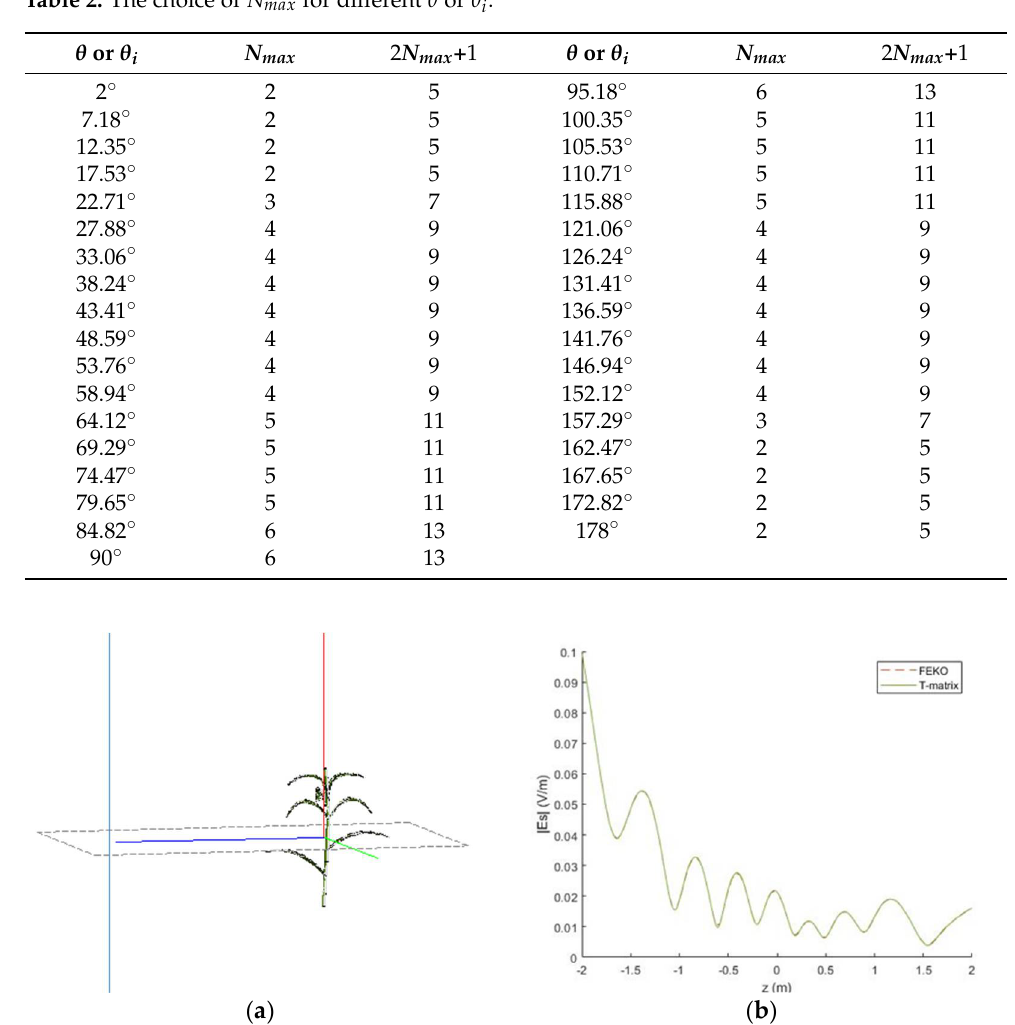
Figure 6. Tree trunks ( left ) are modelled as dielectric cylinders ( right ). The Figure is adapted with permission from Ref. [2]. © 2019 IEEE. Table 3. Transmission coefficient from RTE based on distorted Born approximation (RTE/DBA) and the hybrid method from Figure 6. The table is adapted with permission from Ref. [2]. © 2019 IEEE. RTE/DBA